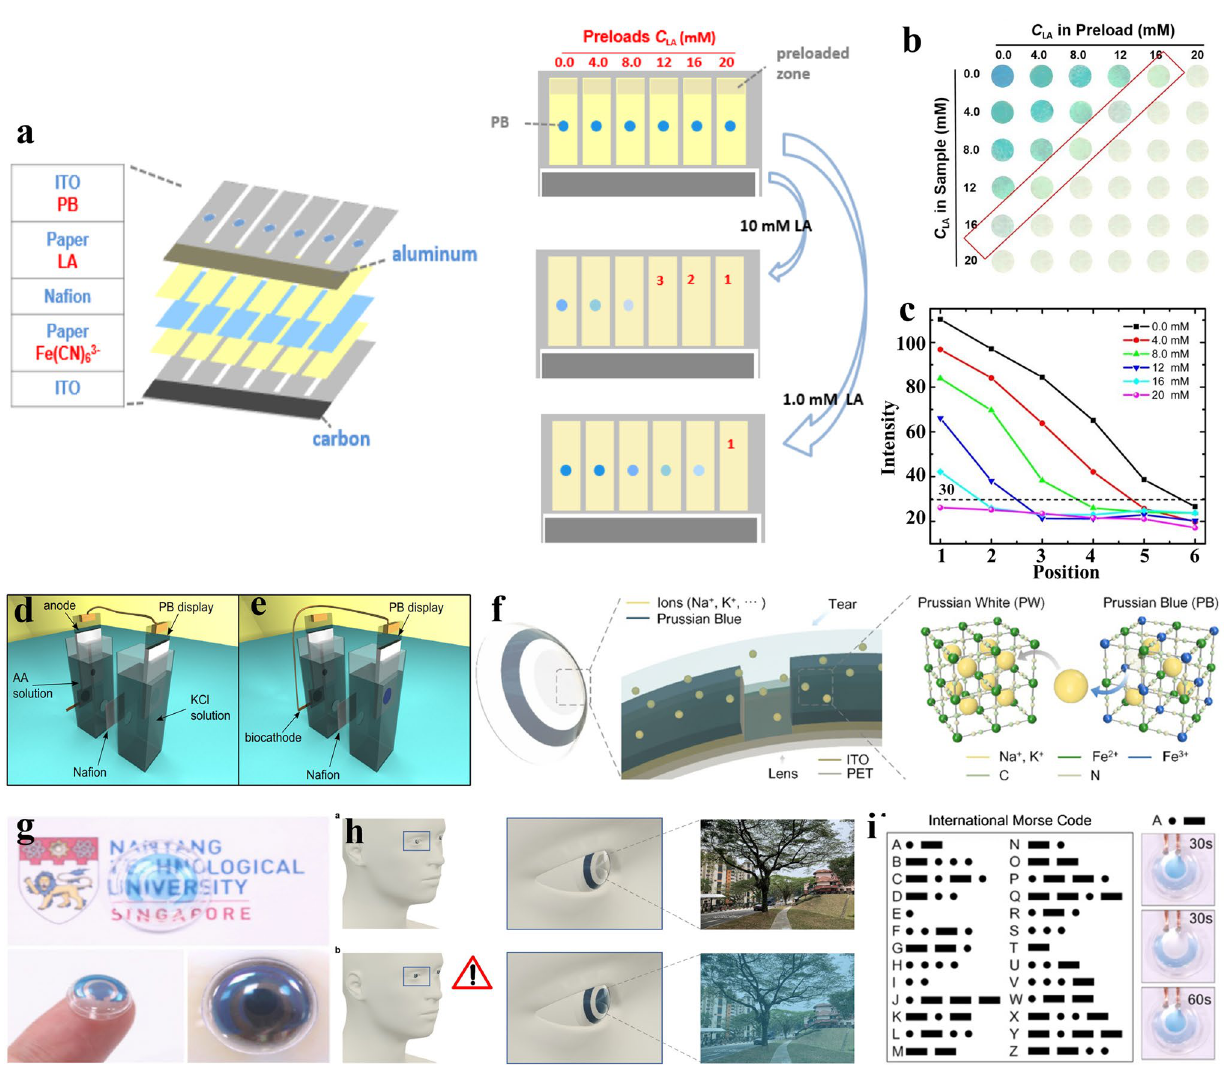
Fig. 13 Advances in MERABs sensors. a Schematic illustration of the structure and working principle. b Photographs of the PB spots on the LA electrochromic array. c Color intensity of the PB spots shown in b as a function of LA concentration. Reproduced with permission [33]. Copyright 2017, MDPI. d, e Schematic illustration of a self-powered biosensor. Reproduced with permission [140]. Copyright 2014, Elsevier. f Schematic image of electrochromic alarm system on contact lens. g Digital photographs of electrochromic contact lens. h Transparent vision on smart contact lens in the safe situation, and color changing in the emergency situation. i Morse code in electrochromic alarming system. By con- trolling the time duration of color change. Reproduced with permission [34]. Copyright 2020,